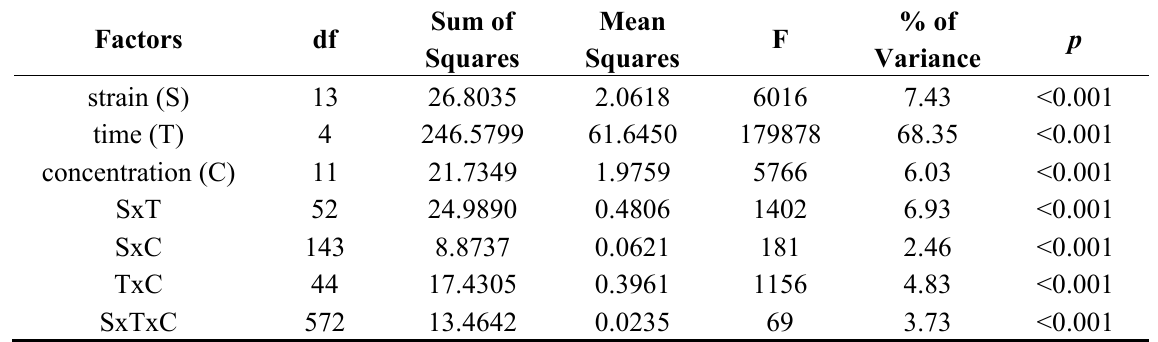
Table 2. Multivariate analysis of variance by three-way ANOVA of CoNS susceptibility to berberine. Factors df